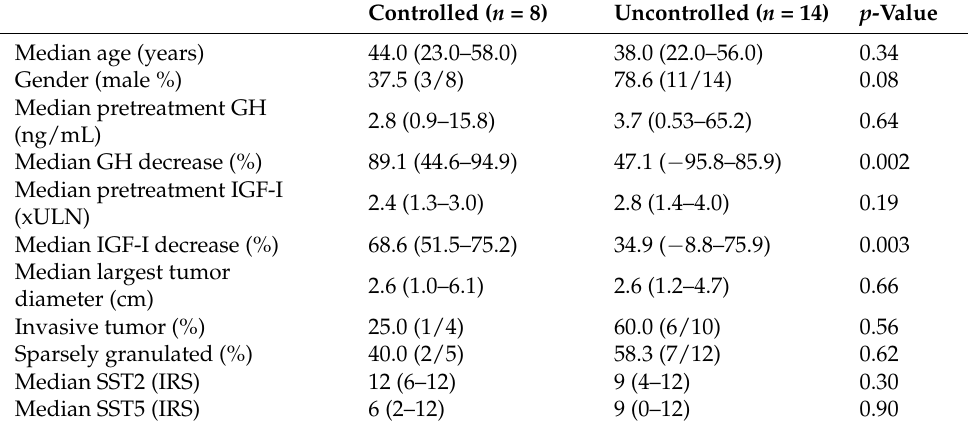
Table 3. Characterization of patients used for biological validation by qPCR.